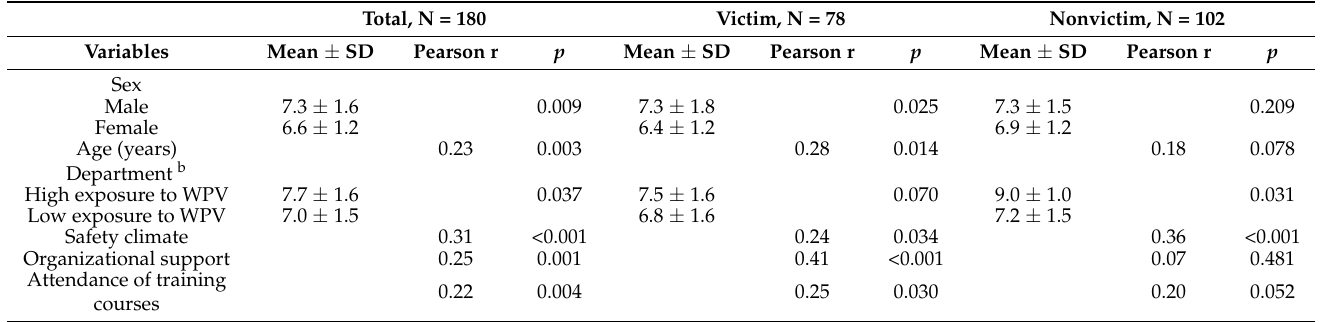
Table 2. Univariate analysis of physicians’ confidence in handling WPV a and associated factors.